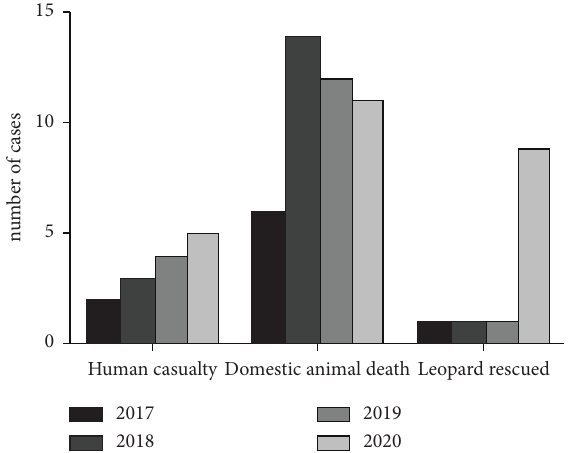
Figure 9: Observations in the Bijnor area of Hastinapur wildlife sanctuary regarding human casualties, killing of human domesticated animals, and leopards